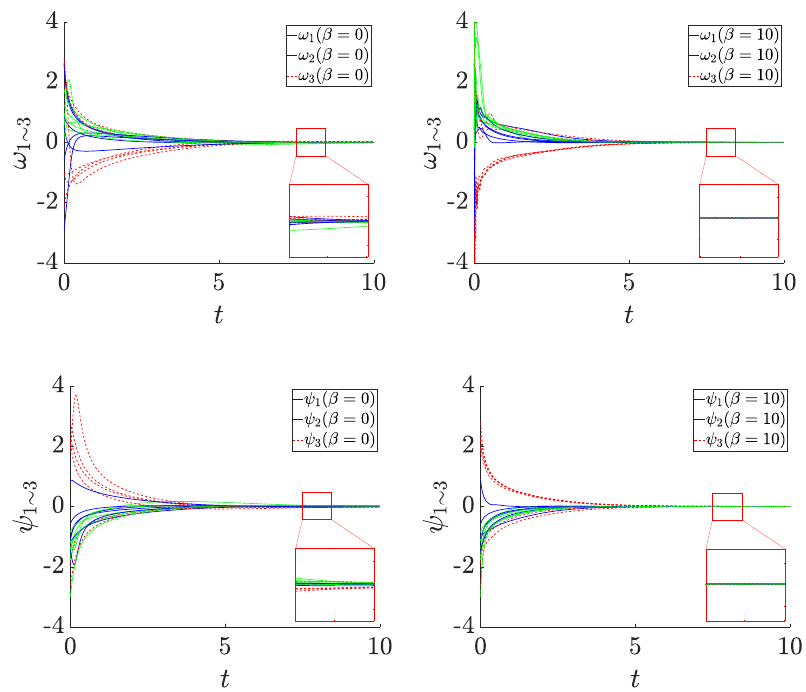
Figure 4. Rigid body system stabilized by our proposed